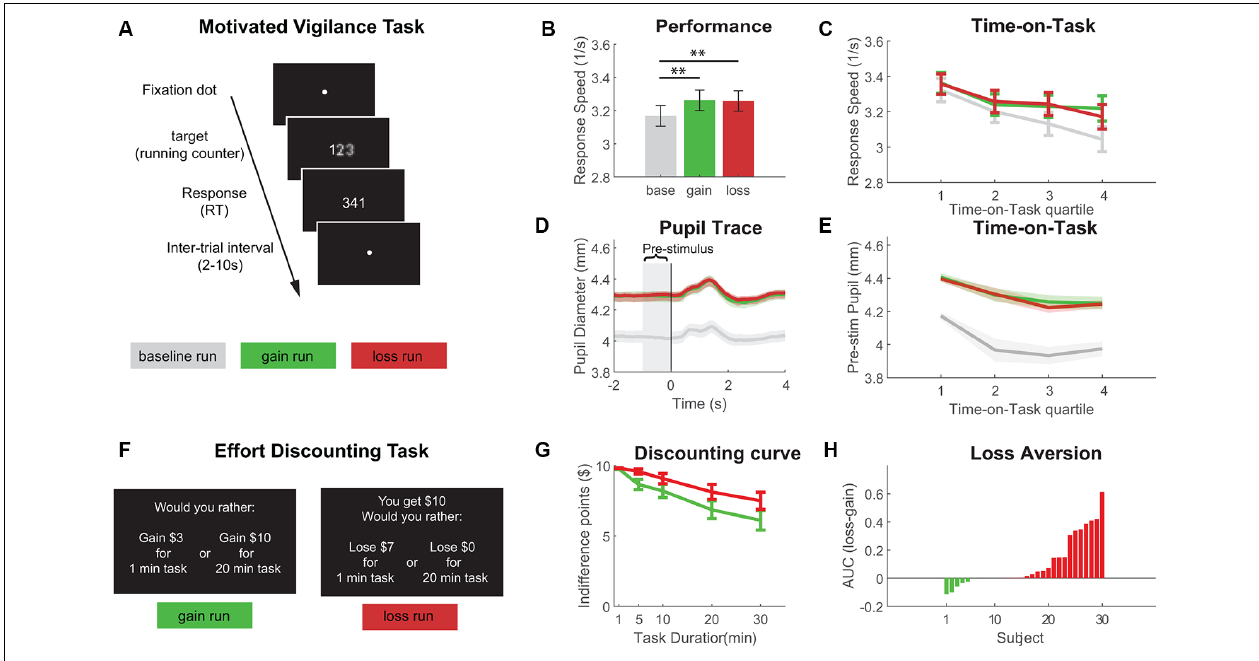
FIGURE 1 | Results from Experiment 1 with (A) schematic of the Motivated Vigilance Task, (B) response speed in the vigilance task for baseline, gain and loss conditions, (C) Time-on-Task decline of response speed (Time-on-Task quartiles for illustrative purposes, statistical analysis was based on linear slopes), (D) target-locked pupil trace in the vigilance task (time = 0 indicates target presentation), (E) Time-on-Task decline of pre-stimulus pupil diameter (Time-on-Task quartiles for illustrative purposes only, statistical analysis was based on linear slopes), (F) example trials of the effort-discounting task, (G) effort-discounting curve, and (H) loss-gain difference in the area under the discounting curve (AUC; positive difference scores denote less discounting for loss vs. gain choices). ∗∗ p < 0.01.